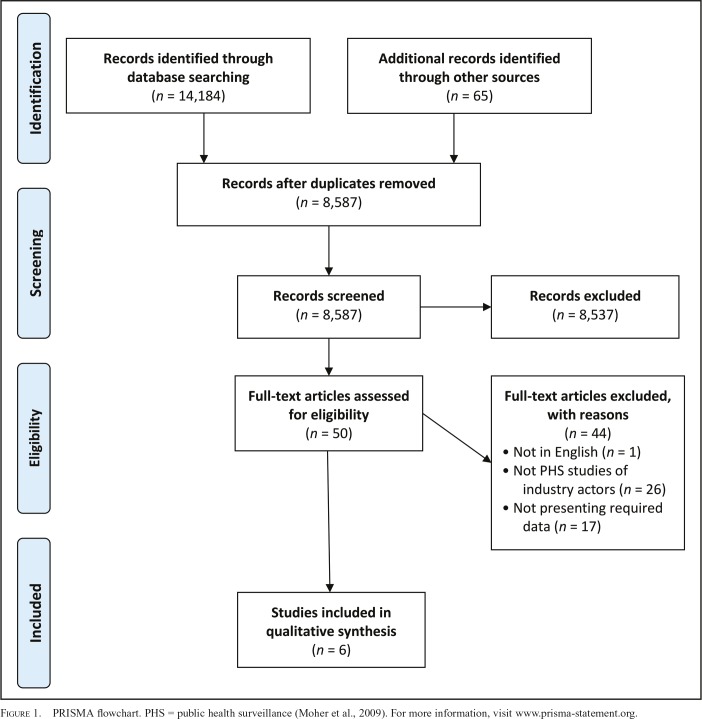
. PRISMA flowchart. PHS = public health surveillance (Moher et al., 2009). For more information, visit www.prisma-statement.org.